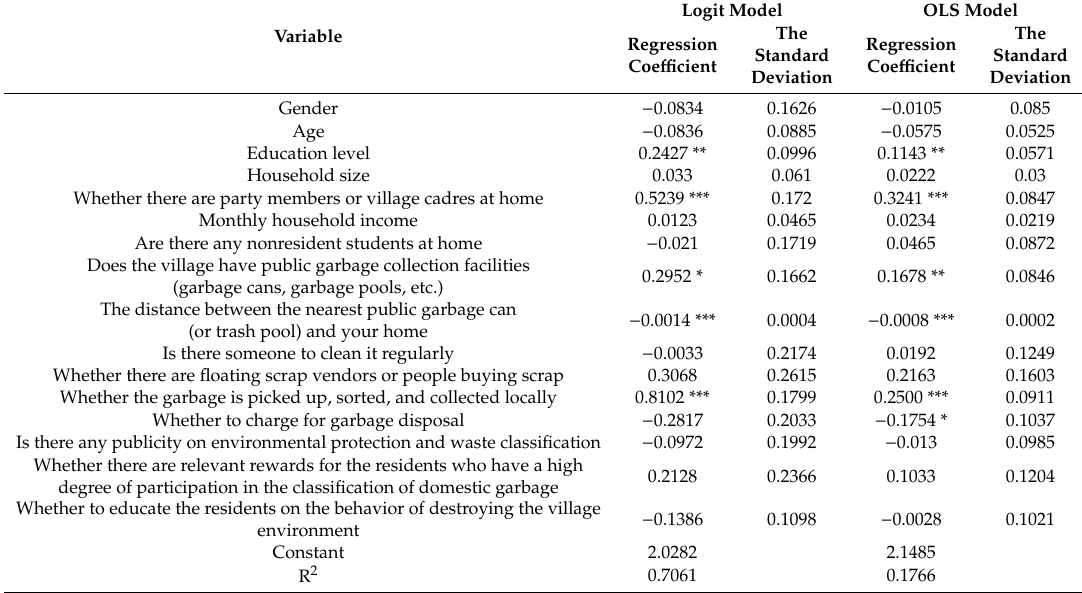
Table 4. Household environmental protection